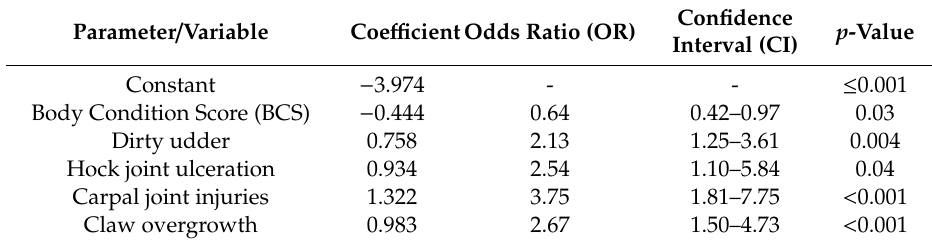
Table 4. Binary logistic regression of lameness with other animal-based welfare parameters in shelter cows (n =